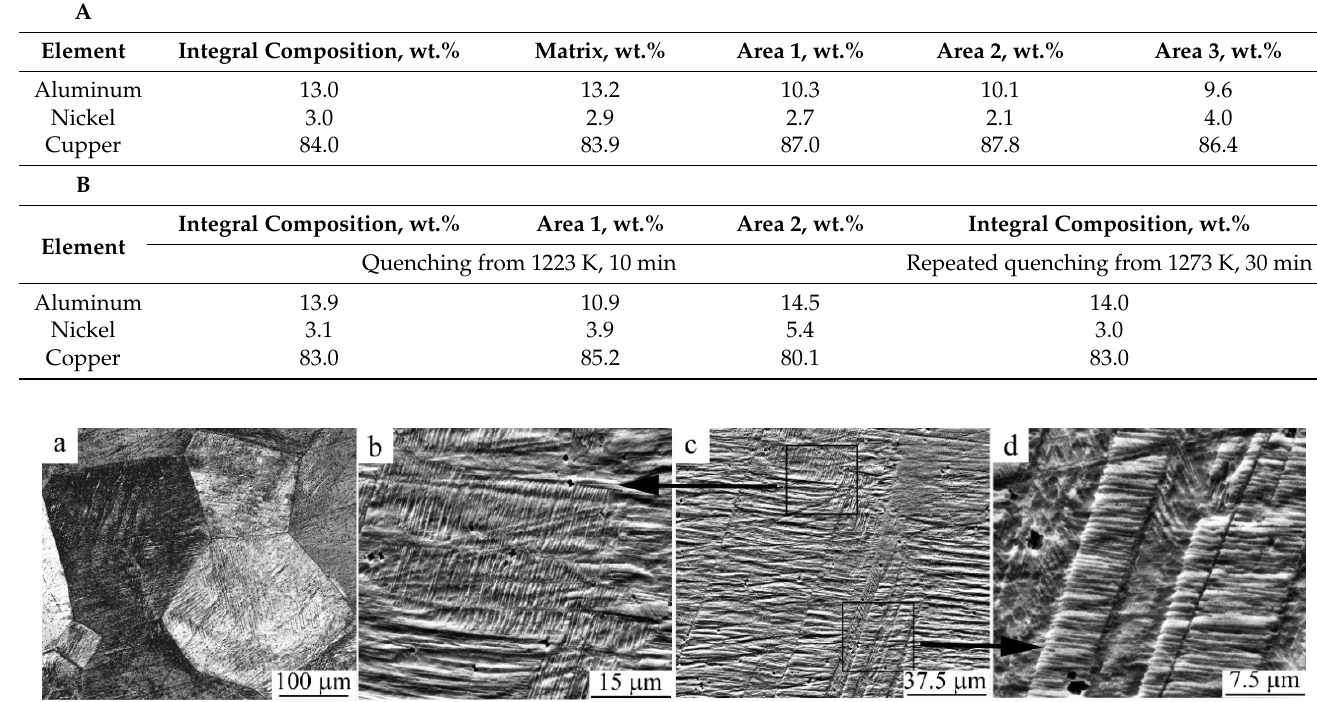
Table 3. Data of chemical X-ray microanalysis of the ( A ) Cu-13 wt.%Al-3 wt.%Ni after quenching from 1223 K, 10 min in water and ( B ) Cu-14 wt.%Al-3 wt.%Ni after quenching from 1223 K, 10 min in water and repeated quenching from 1273 K, 30 min in water at RT.